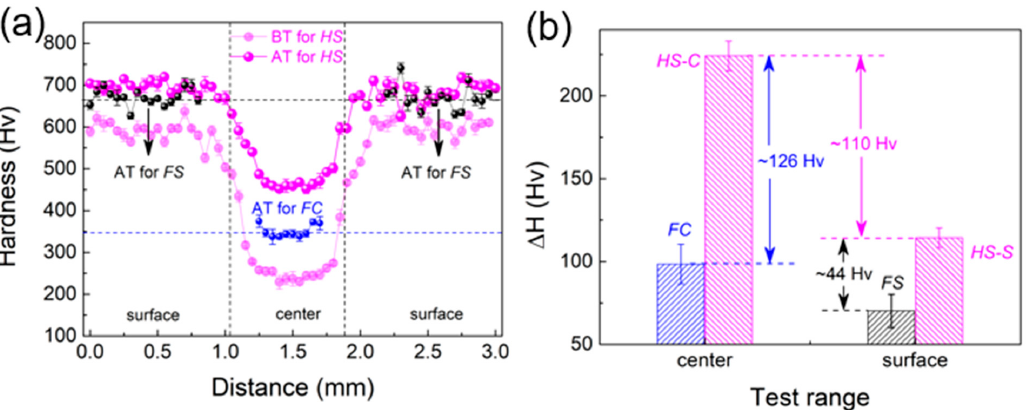
Figure 10. ( a ) Hardness distribution of FC, FS, and HS samples after tensile deformation along the scale width direction; ( b ) hardness difference before and after tension within the central core and surface layers.